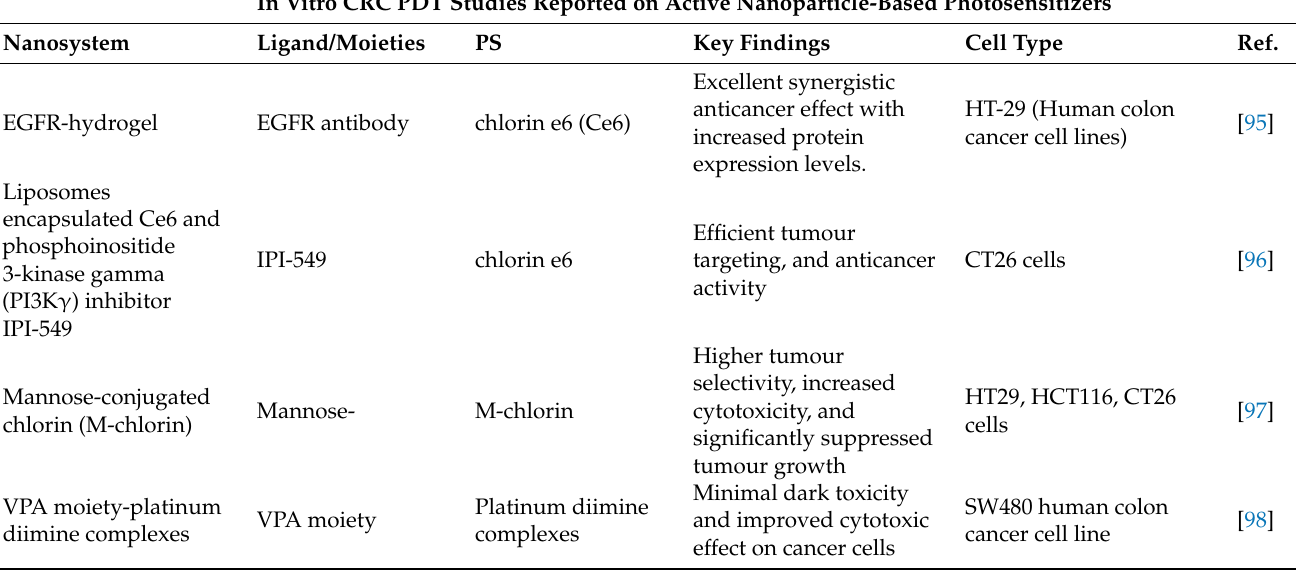
Table 3. In vitro and in vivo CRC PDT studies reported on active nanoparticle-based photosensitisers. In Vitro CRC PDT Studies Reported on Active Nanoparticle-Based